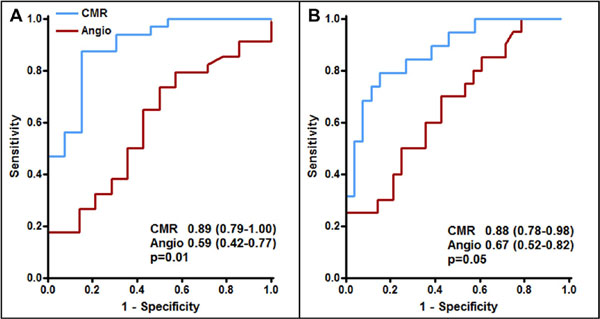
Diagnostic performance of cardiovascular magnetic resonance myocardial perfusion reserve and angiography for detecting cardiac allograft vasculopathy (CAV). Diagnostic performance of cardiovascular magnetic resonance myocardial perfusion reserve (CMR) and angiography (angio) for detecting; (A) moderate cardiac allograft vasculopathy, defined as > median epicardial or microvascular disease; and (B) severe cardiac allograft vasculopathy, defined as > 75th centile epicardial or microvascular disease.